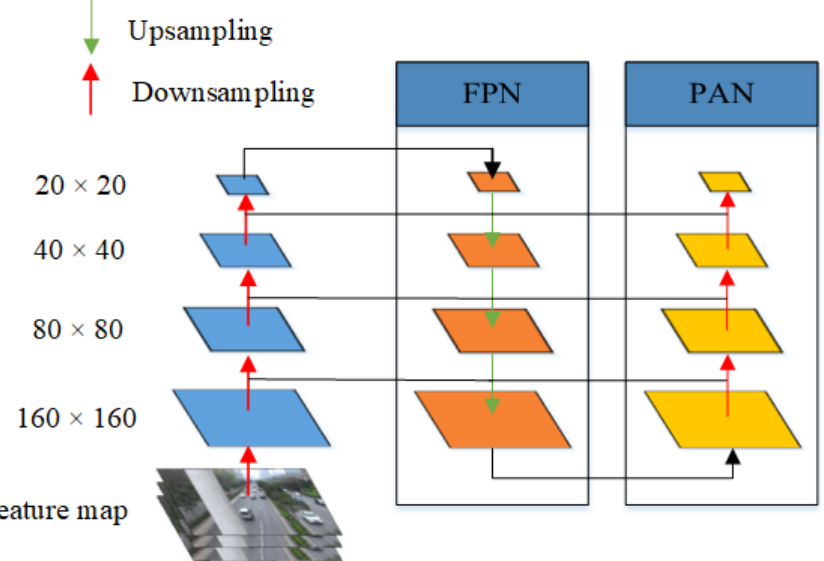
Figure 3. The structure of the multi ‐ scale integration.